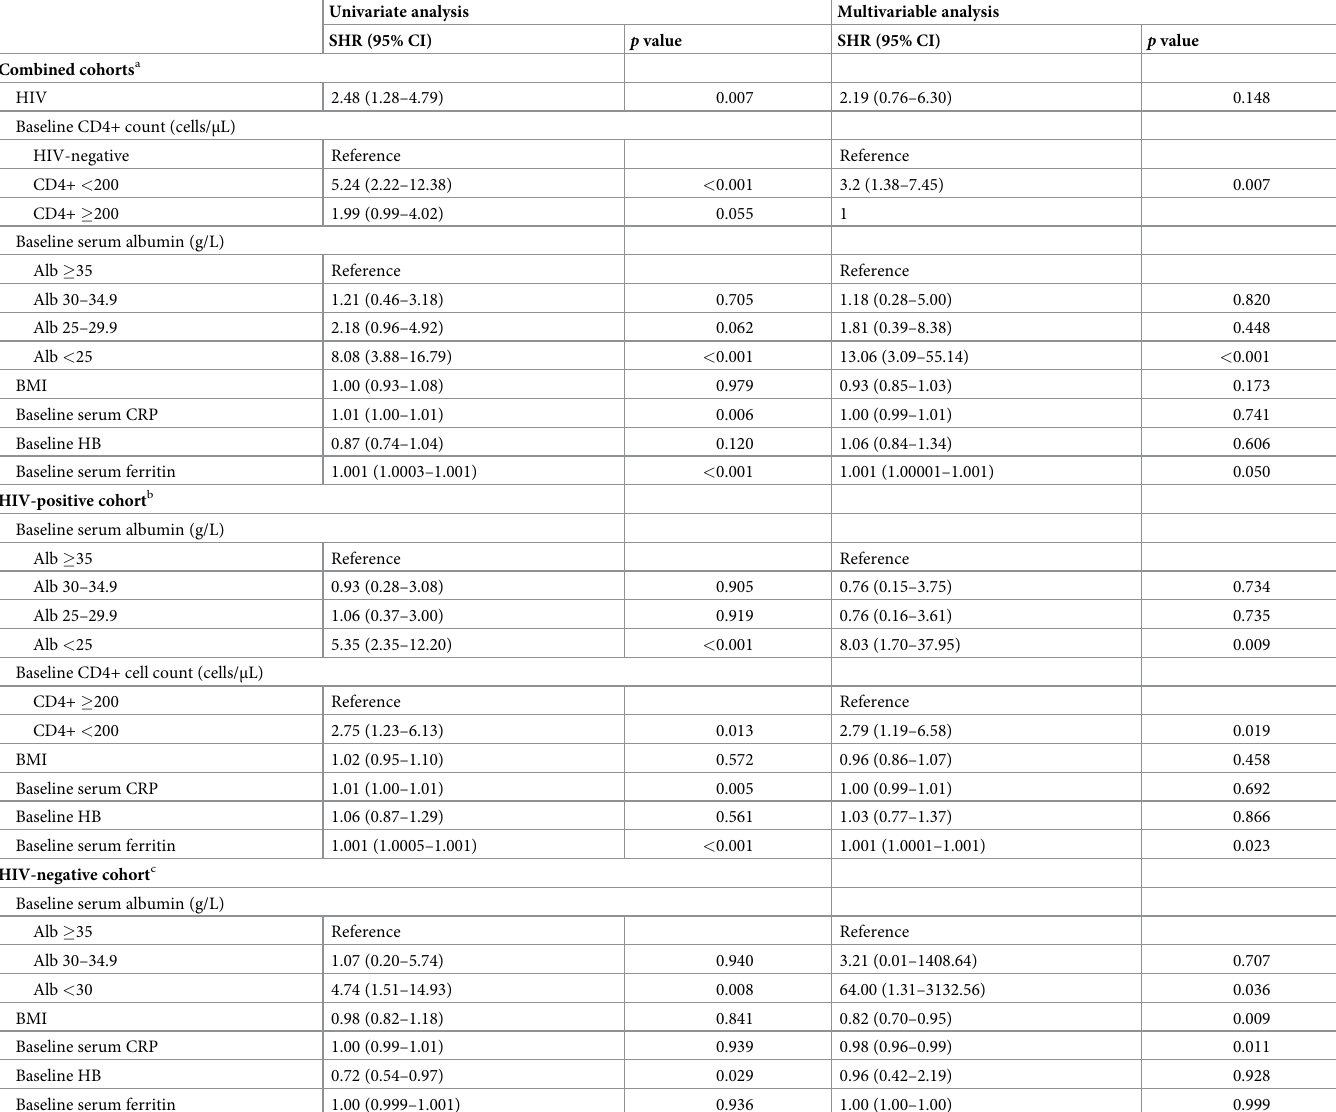
Table 5. Univariate and multivariable competitive risk analysis for cumulative incidence of mortality with technique failure as a competing risk